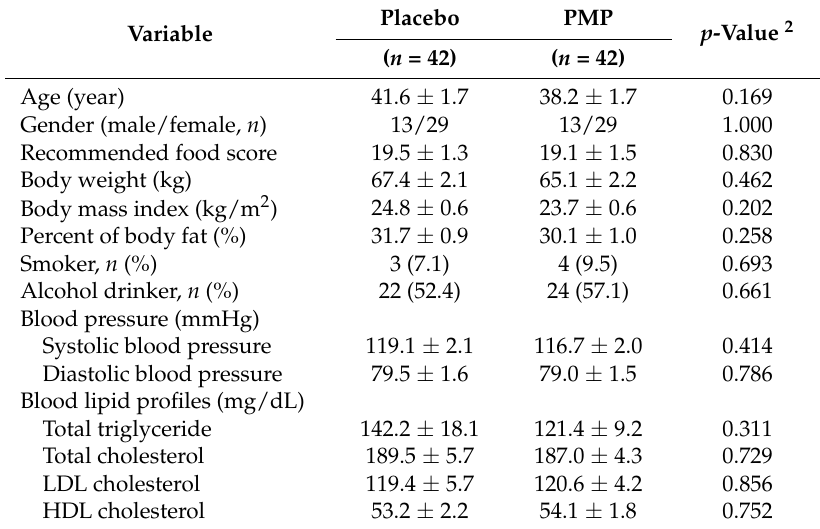
Table 1. Baseline characteristics of subjects 1 .